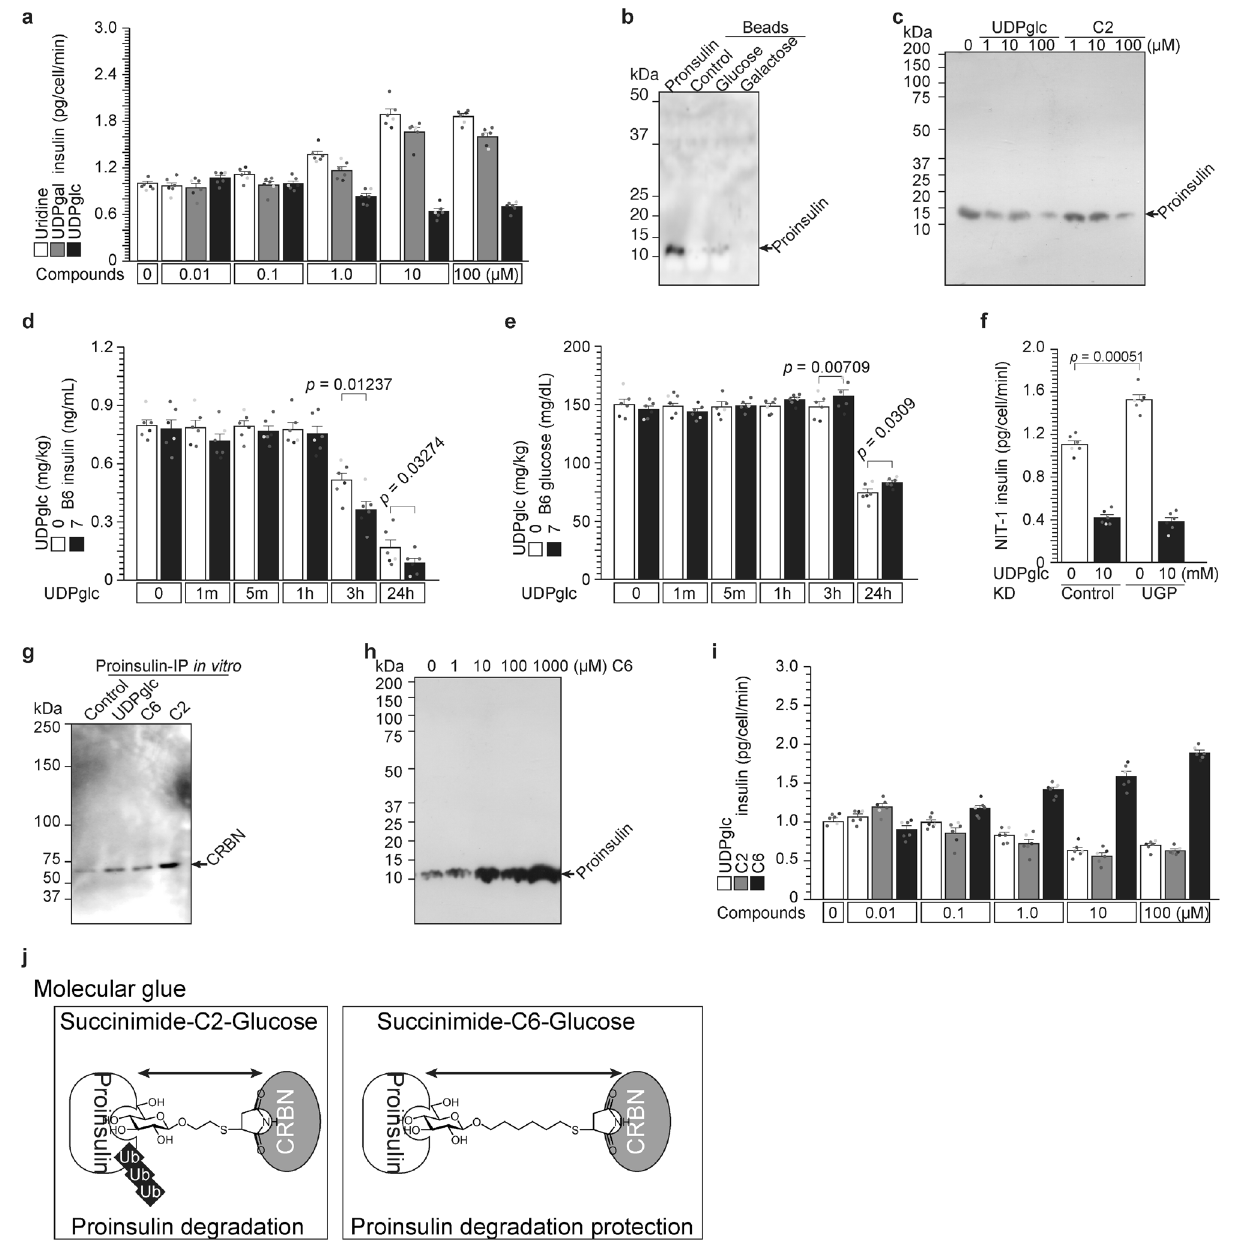
Figure 5. UDP-glucose is an endogenous proinsulin protein degrader through cereblon. ( a – c ) The proinsulin protein degrader X is UDP-glucose. Uridine and UDP galactose administration increased insulin secretion (Fig. 4), although UDP glucose decreased insulin secretion in a dose-dependent manner (a). Proinsulin binds to glucose but does not bind to galactose ( b ). UDP glucose and succinimide-C2-glcuose degraded proinsulin protein ( c ). ( d and e ) Administration of the proinsulin protein degrader UDP-glucose to C57/BL6J mice decreased circulating insulin ( d ) and increased glucose concentration ( e ). ( f ) Significant higher insulin secretion in UGP KD cells 31 . ( g – j ) Succinimide-glucose degrades or protects proinsulin. ( g ) Succinimide-C2-glucose strongly stimulates the proinsulin and cereblon interaction in vitro. ( h ) Succinimide-C6-glucose protects endogenous UDP-glucose-dependent proinsulin degradation in a dose-dependent manner. ( i ) UDP glucose and succinimide-C2-glucose reduced insulin secretion in a dose-dependent manner, although succinimide- C6-glucose induced insulin secretion (like UDP-galactose). ( j ) Possible model of molecular glue with/without proinsulin